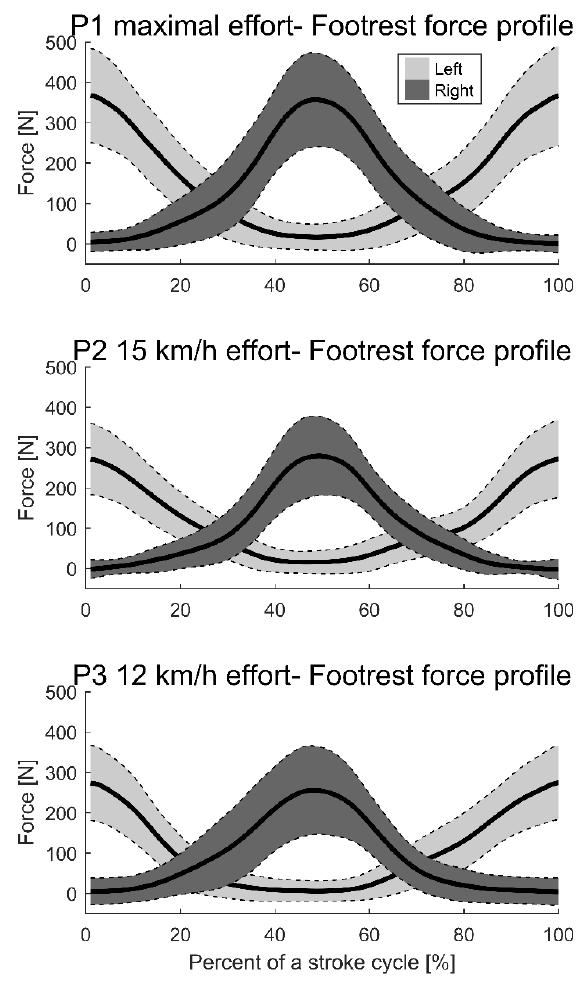
Figure 3. Mean force of stroke cycles for each velocity with standard deviation. Light grey shows the left; dark grey shows the right. P1 is the maximal effort, P2 is 15 km/h, and P3 is 12 km/h. The x-axis presents the stroke cycle from the left side until the return to the left side, and the y-axis shows the force in Newtons. Data are normalized to the left side using the force on the left footrest. The start of the stroke cycle at 0% is when the force on the left footrest peaks. The end of the second stroke at 100% is when the force on the left footrest peaks for the second